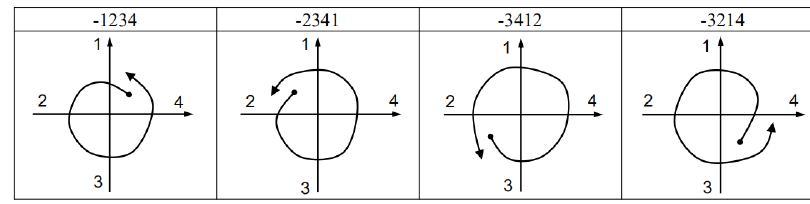
Figure 7. Code templates and schematic diagrams of counterclockwise circles.